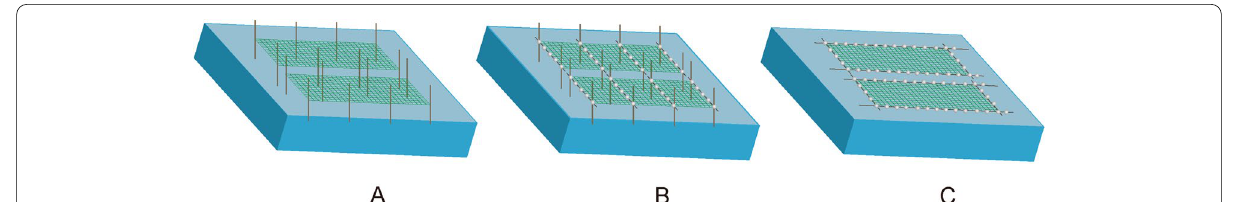
Fig. 5 Three farming techniques of seaweed. A: pillar type; B: Semi floating raft: C: full floating raft composed of long rope and floating